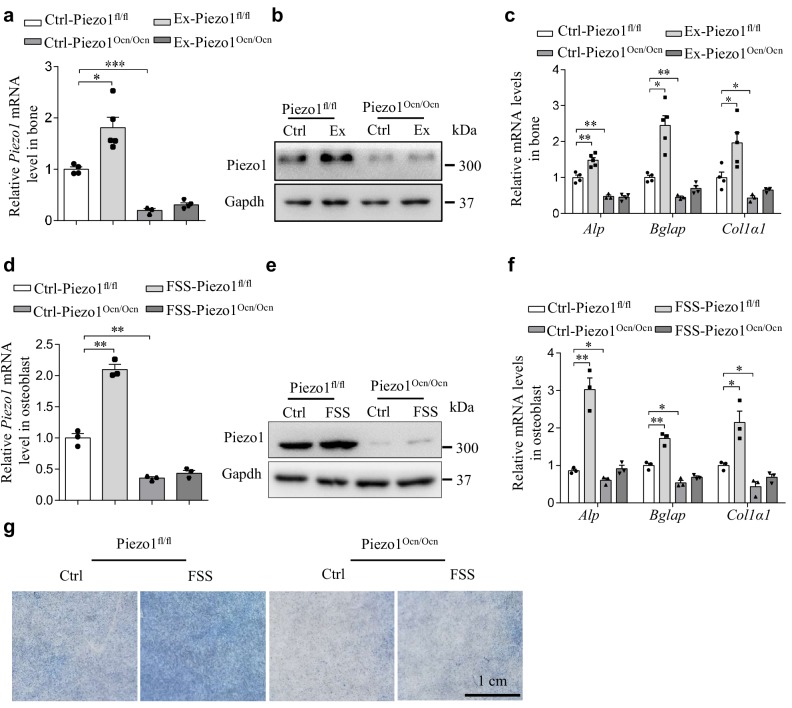
Mechanical loading promotes Piezo1 expression in osteoblasts.(a, b) QRT-PCR analysis of Piezo1 mRNA level (a) and Western blotting analysis of Piezo1 protein level (b) in bone tissues from the groups of mice with the indicated treatment conditions. Ex, Exercise. Ctrl-Piezo1fl/fl group, n = 4; Ex-Piezo1fl/fl group, n = 5; Ctrl-Piezo1Ocn/Ocn group, n = 3; Ex-Piezo1Ocn/Ocn group, n = 4. (c) QRT-PCR analysis of Alp, Bglap and Col1α1 mRNA levels in bone tissues collected from the groups of mice as indicated above. (d, e) QRT-PCR analysis of Piezo1 mRNA level (d) and Western blotting analysis of Piezo1 protein level (e) in osteoblasts isolated from Piezo1fl/fl and Piezo1Ocn/Ocn mice under control (Ctrl) and fluid shear stress (FSS) conditions. (f) QRT-PCR analysis of Alp, Bglap and Col1α1 mRNA levels in osteoblasts isolated from the indicated mice under Ctrl and FSS conditions. (g) Representative images of Alp staining in osteoblasts isolated from the indicated mice under Ctrl and FSS conditions. Scale bar: 1 cm. All data are the mean ± s.e.m. from three independent experiments. *, p<0.05; **, p<0.01; ***, p<0.001.10.7554/eLife.47454.019Figure 6—source data 1.The data and statistical analysis of the effect of mechanicalloading on Piezo1 expression in osteoblasts.